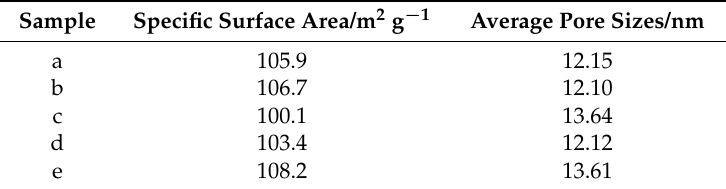
Table 2. The specific surface areas and average pore sizes of the ZnO/BC samples.